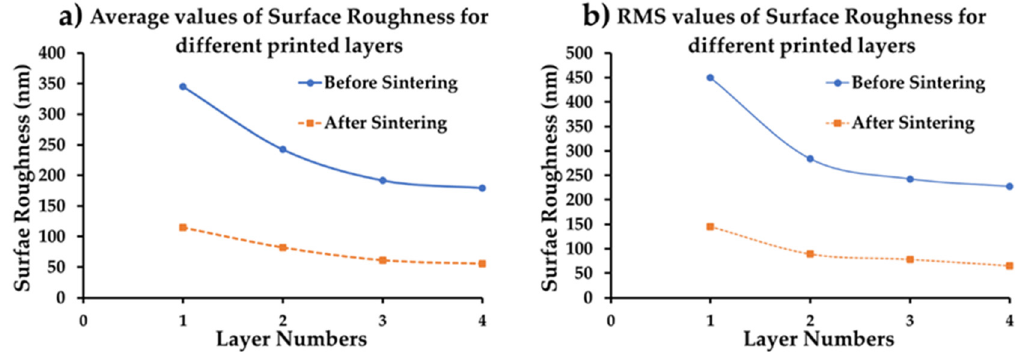
Figure 9. Surface roughness plot for different printed layers before and after sintering ( a ) Average value of surface roughness value, and ( b ) RMS value of surface roughness.